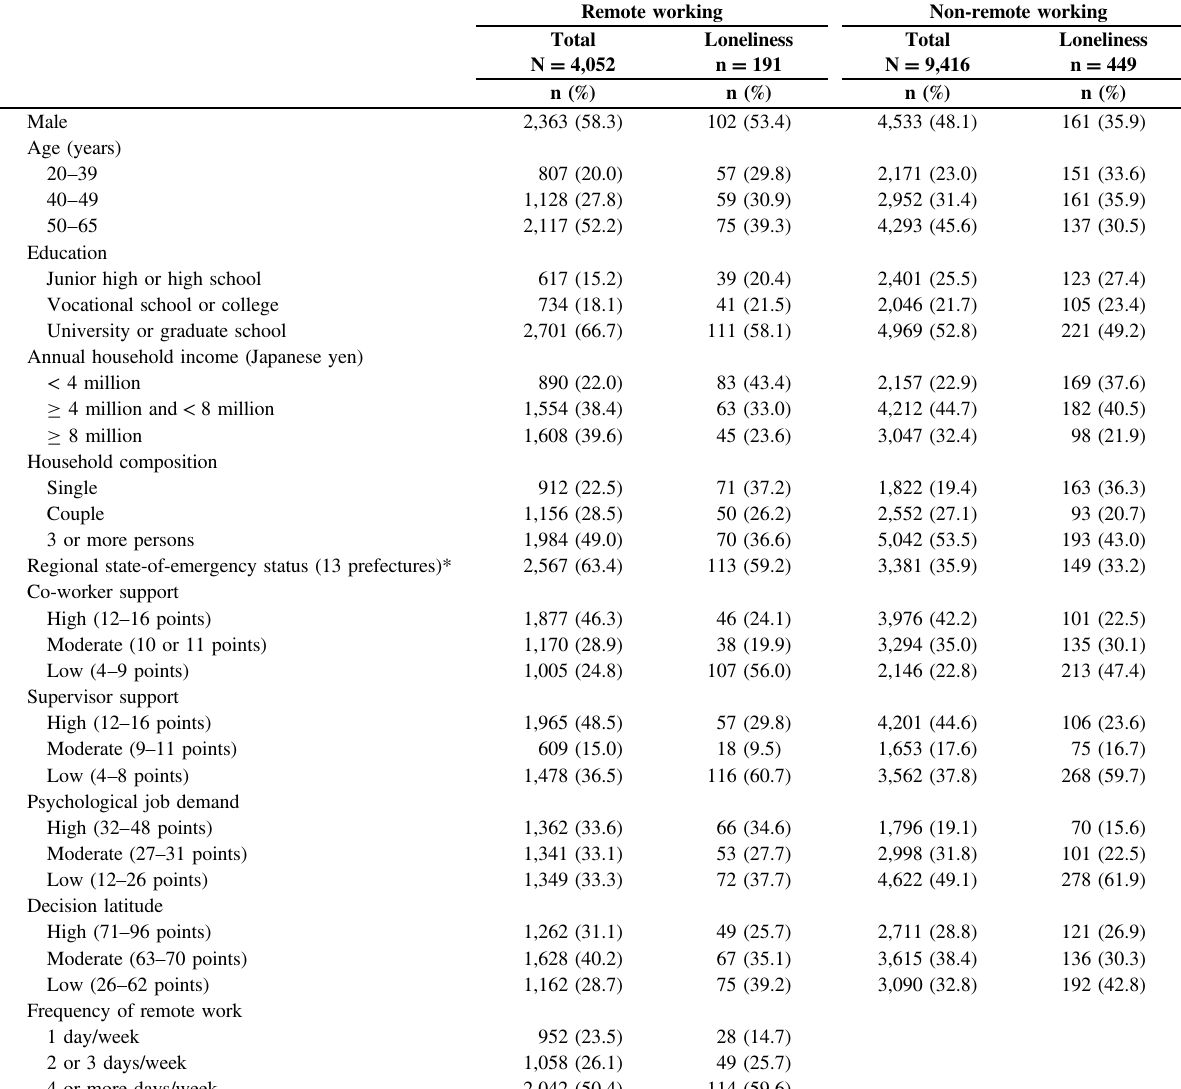
Table 1 General characteristics of the study participants